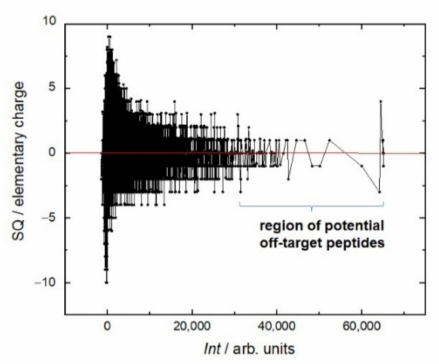
Figure 3. Fluorescent intensity Int of RTX interaction with the resemblance-ranking peptide library versus the sum charge SQ of the corresponding peptides. Here and in further graphs, the black line indicates the neighboring peptides with the growing signal intensity.